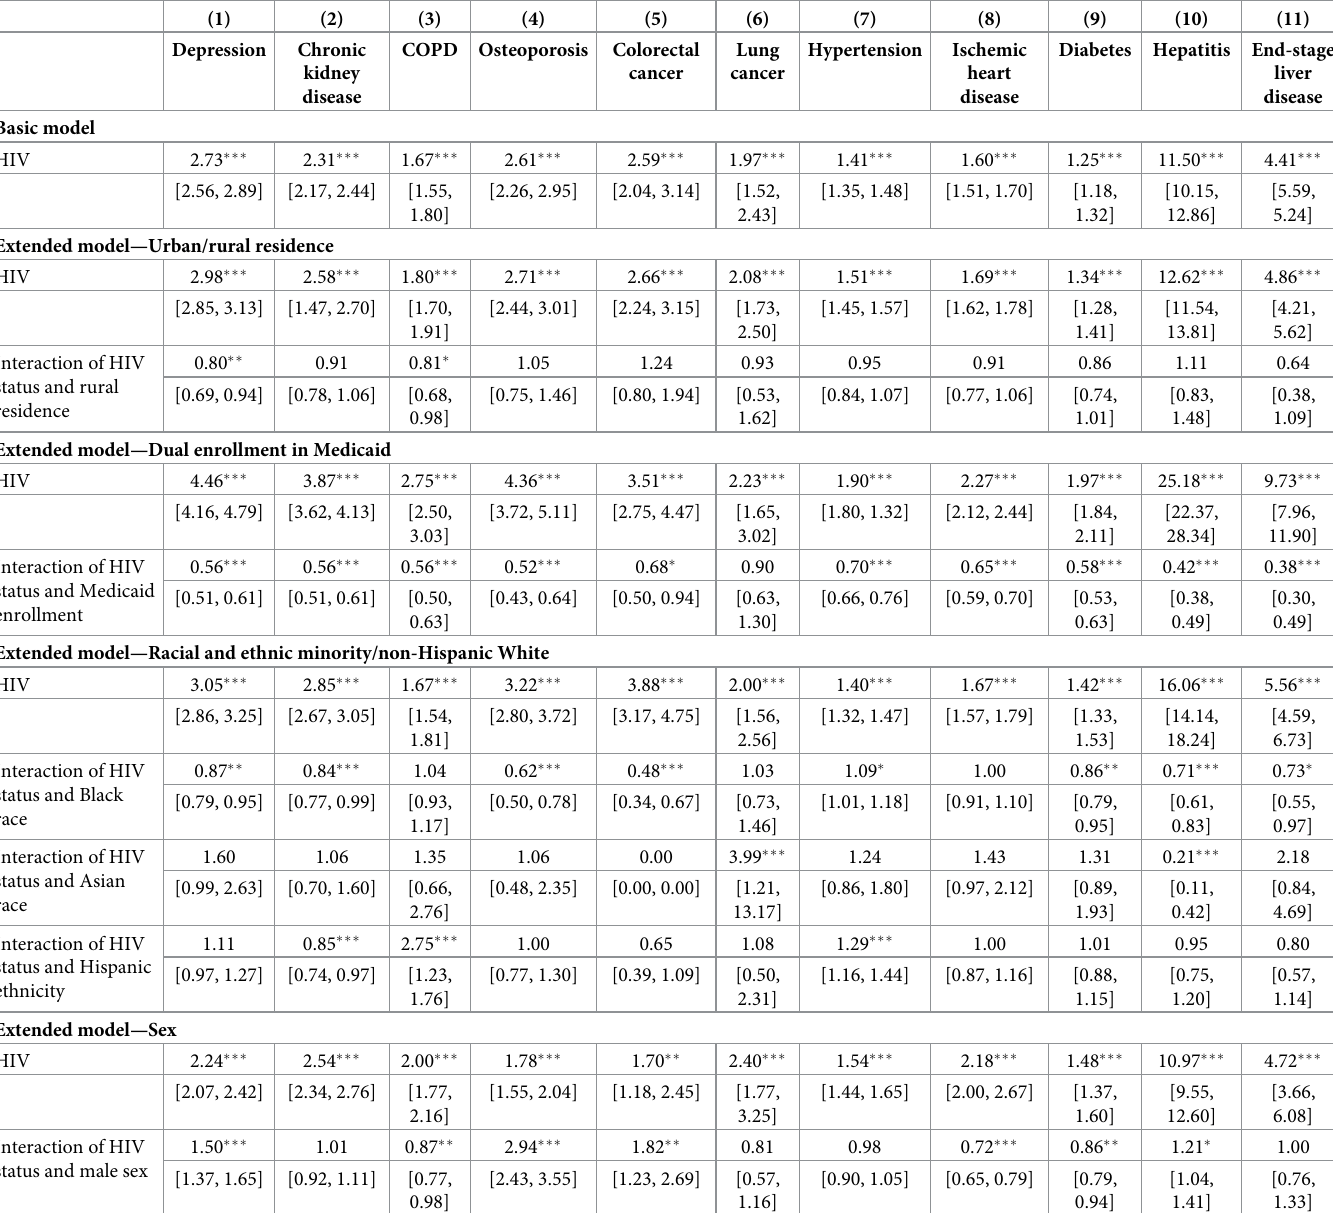
Table 5. Competing risk models of the hazard of developing conditions over time, subhazard ratios reported (Medicare beneficiaries who are observed at age 65 between 2011 and